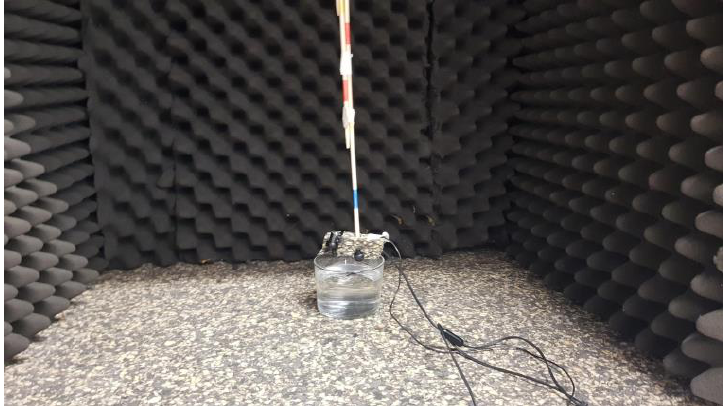
Figure 1. Photograph of the experimental installation.